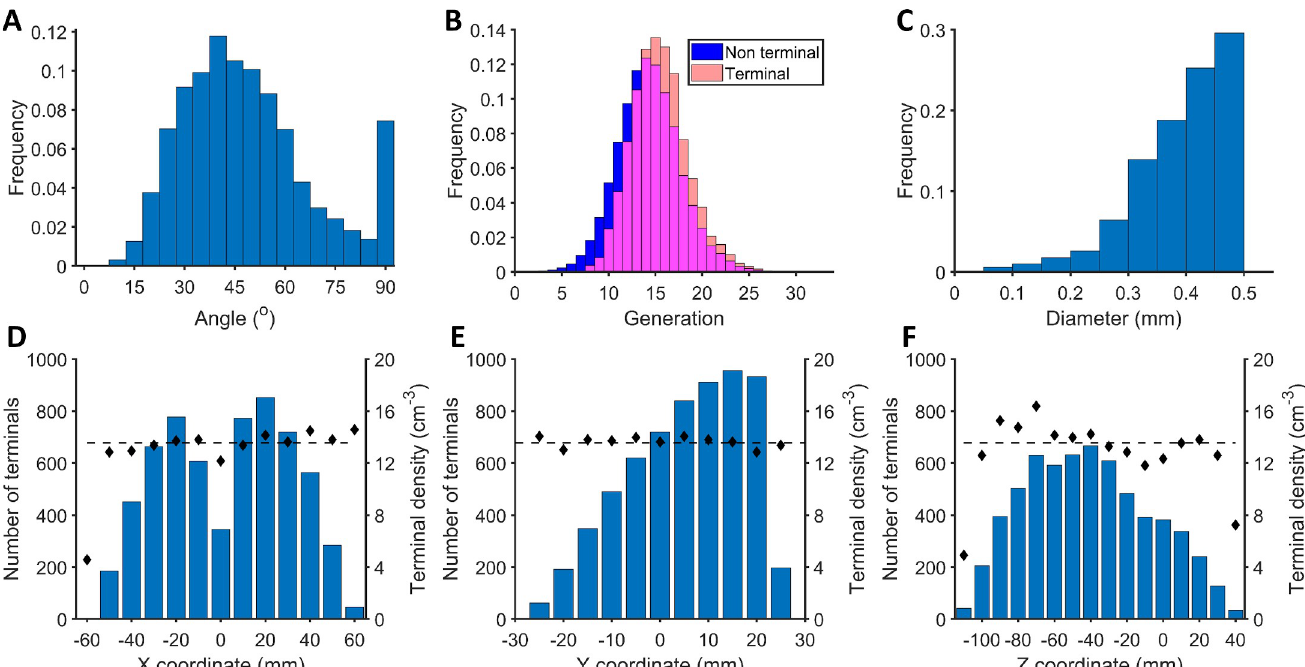
Fig 8. Computational bronchial tree analysis. (A) Angular distribution of bronchial tree bifurcations. The angle is measured between the mother branch and the new one. (B) Generation distribution; in red, the terminal branches, in blue the non-terminal, and in pink the intersection between them. (C) Diameter distribution of the terminal branches. (D) Terminal distribution (blue) and density (black dots) along X coordinate. (E) Terminal distribution (blue) and density (black dots) along Y coordinate. (F) Terminal distribution (blue) and density (black dots) along Z coordinate.